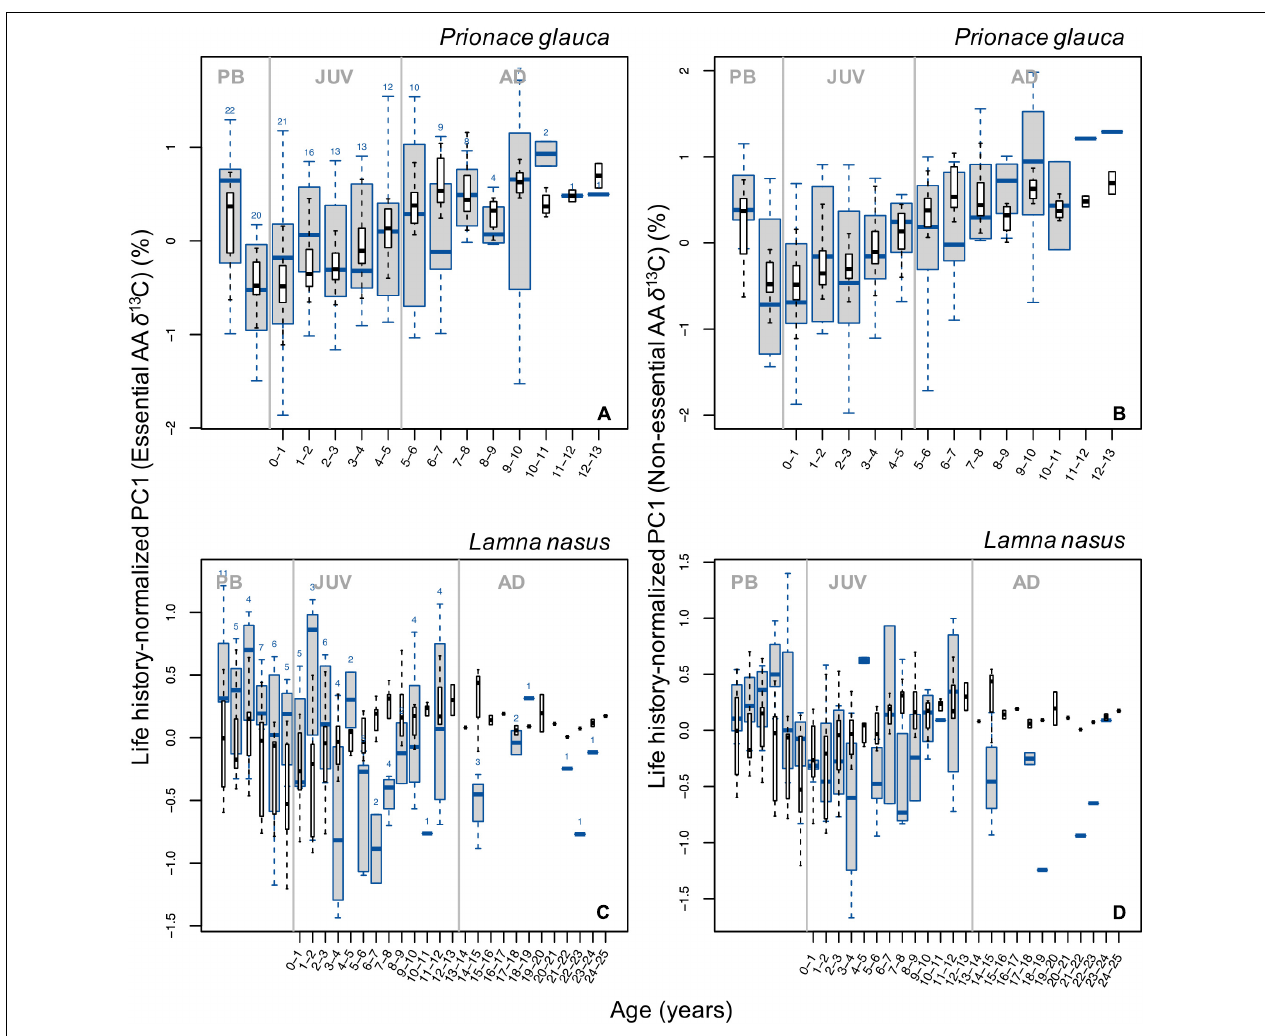
FIGURE 5 | Boxplots (in blue) of life history-normalized PC1 values from PCAs with δ 13 C values of essential (A,C) and non-essential (B,D) amino acids by age class in blue sharks (A,B) and porbeagles (C,D) . Boxplots (in black) of life history-normalized δ 13 C values of bulk protein are overlain for comparison. Figure description is the same as for Figure 2